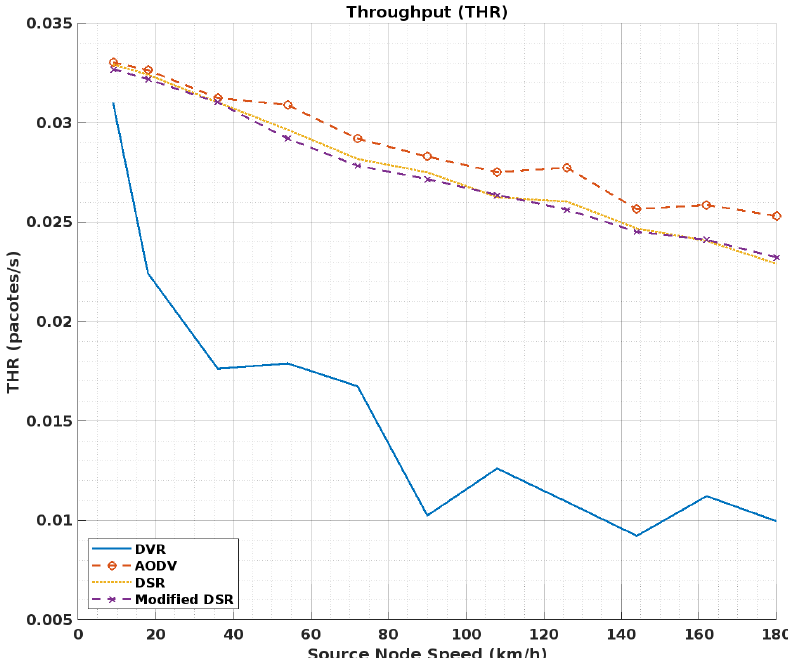
Figure 7. Throughput (THR) as a function of the source node’s speed for the DVR, AODV, DSR, and Modified DSR protocols.